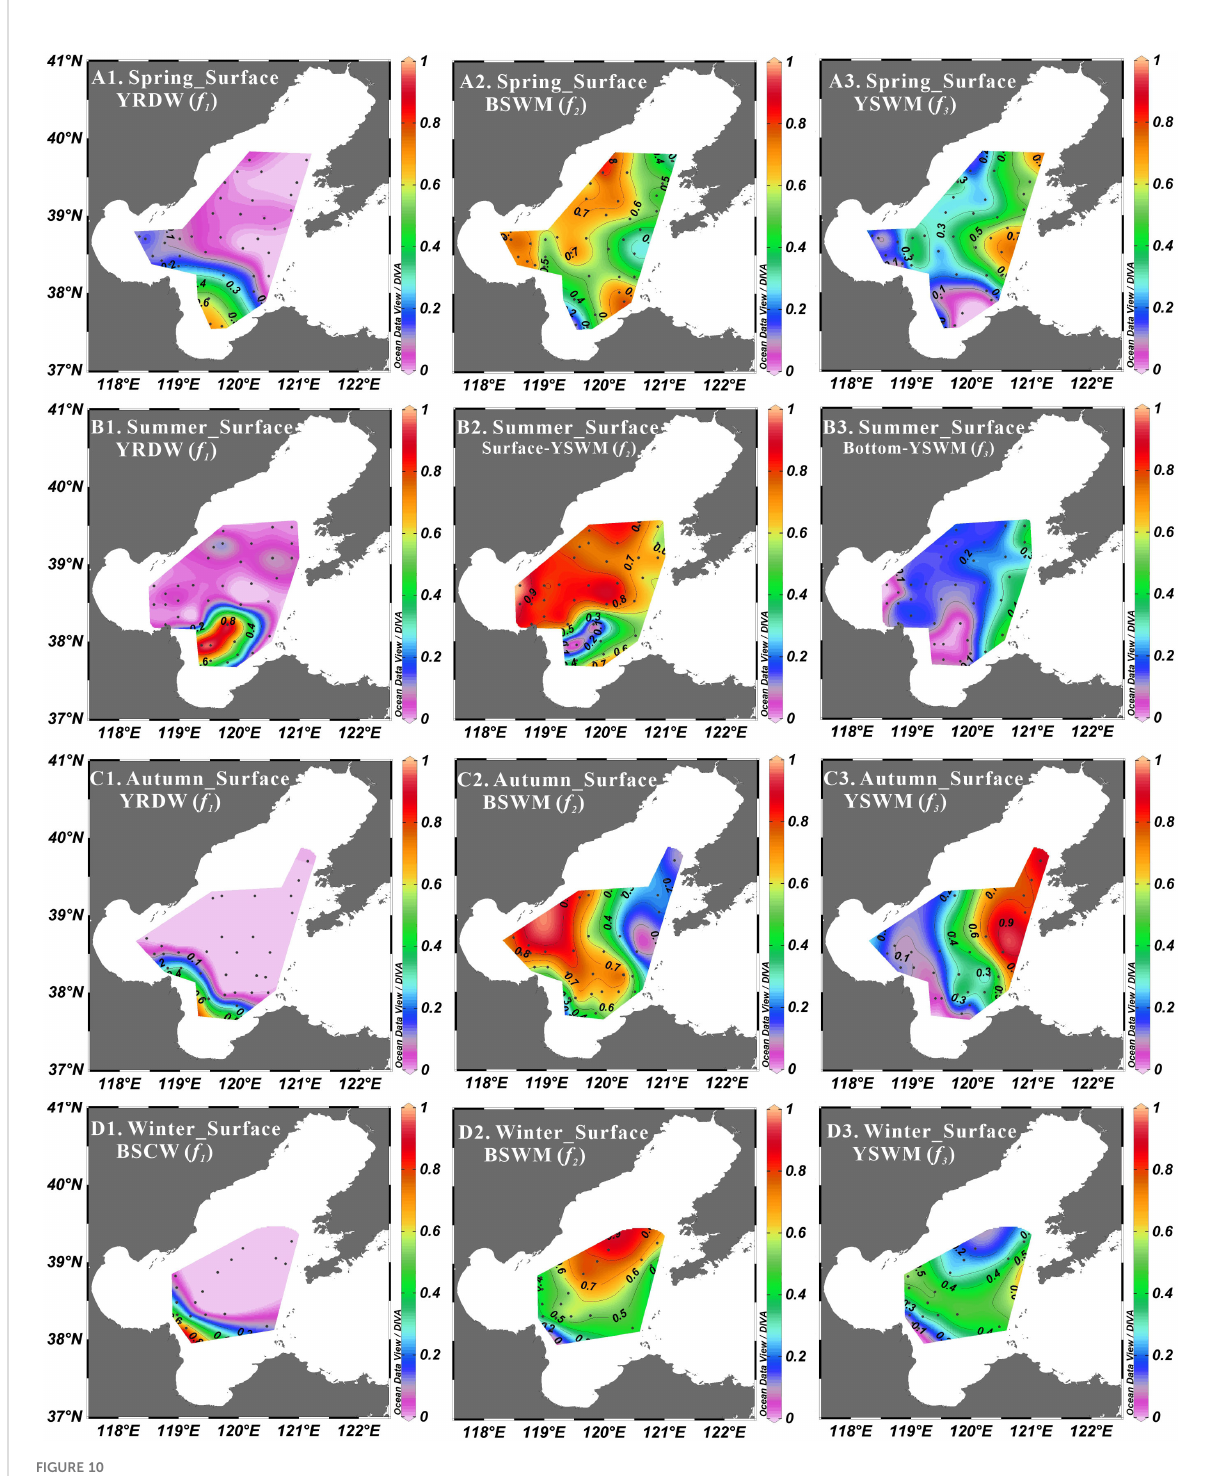
FIGURE 10 Three end-member composite fractions at surface layer in spring (A1, A2, A3), summer (B1, B2, B3), autumn (C1, C2, C3) and winter (D1, D2,